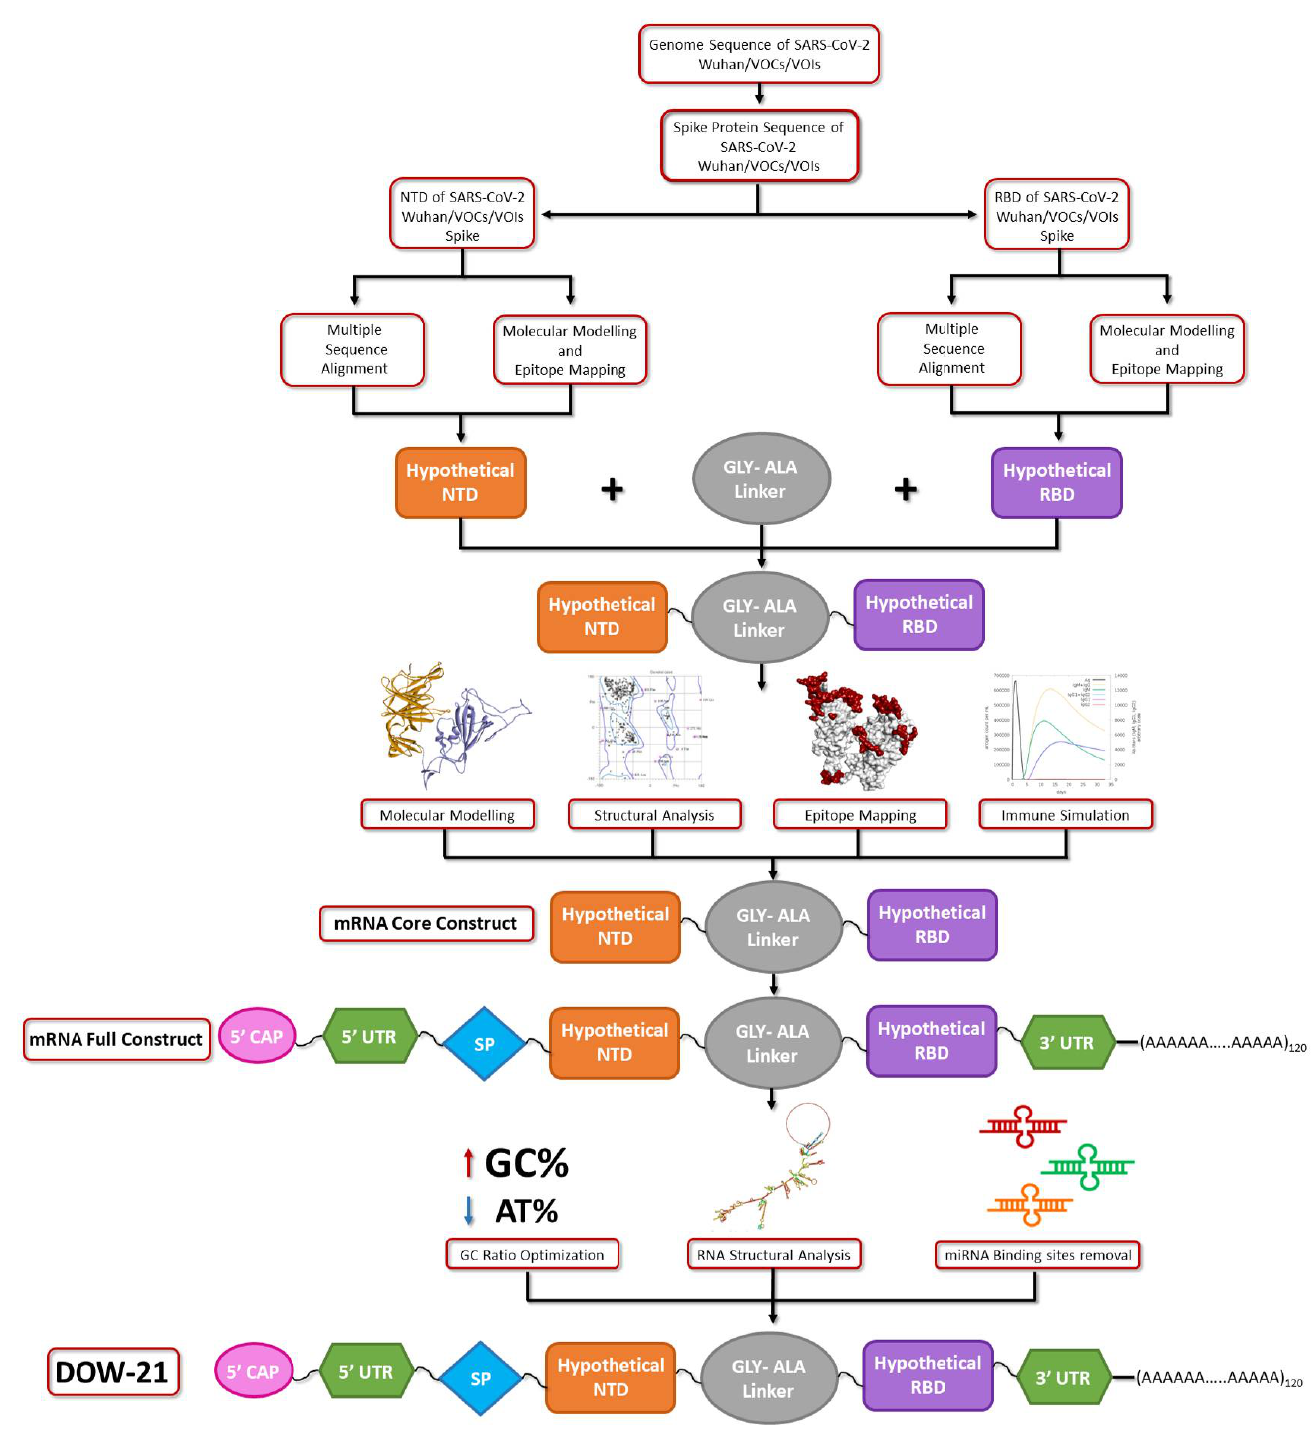
Figure 1. Flow chart of methodology adopted in the present investigation. Key: NTD: N-terminal domain, RBD: receptor binding domain, SP: signal peptide, UTR: untranslated